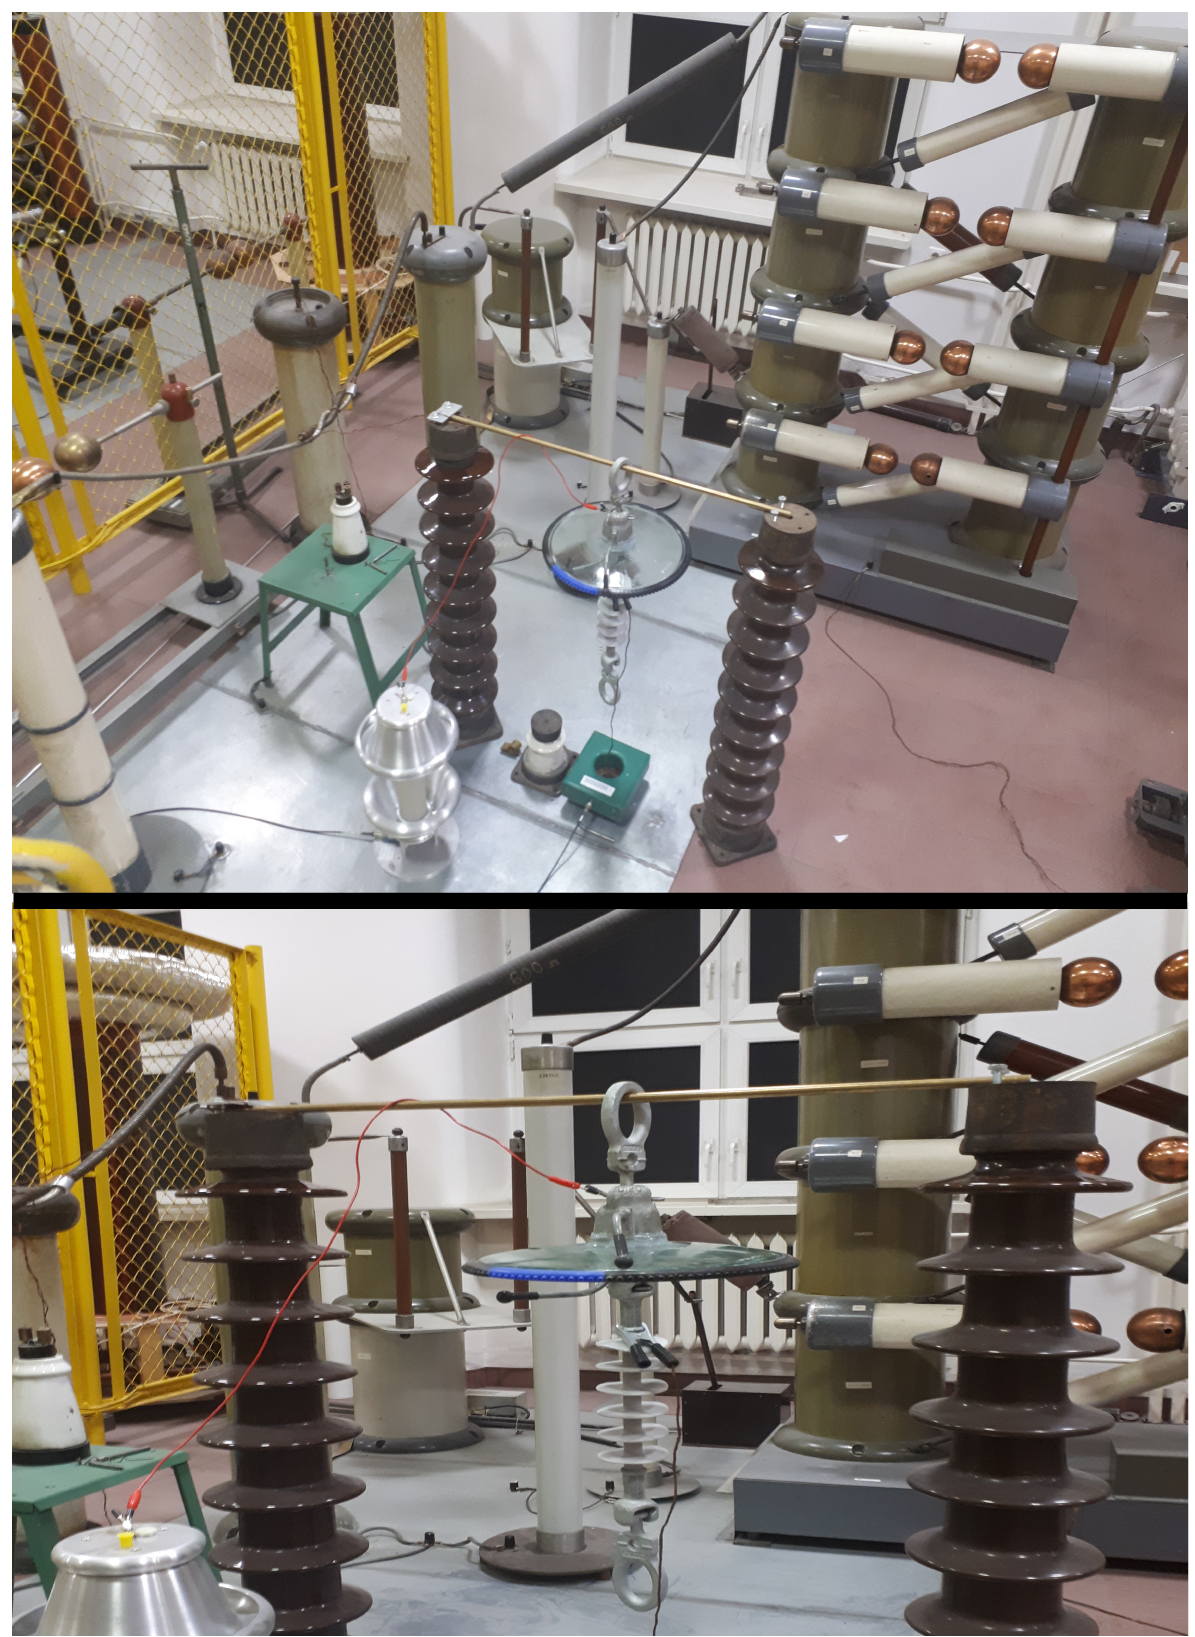
Figure 4. System for testing the MCA device in the field of applying of a voltage lightning